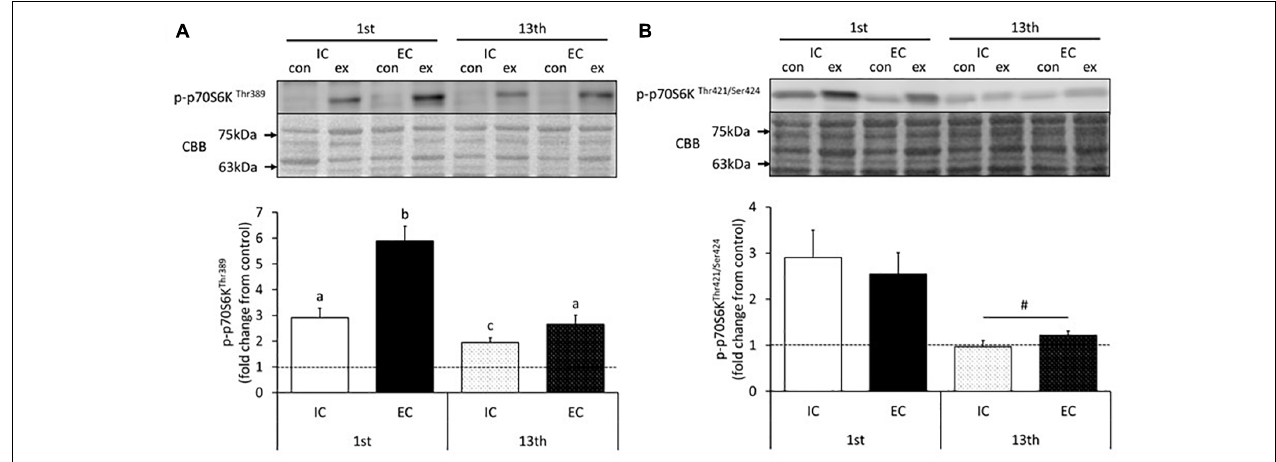
FIGURE 2 | Phosphorylation of p70S6K on Thr389 (A) and Thr421/Ser424 (B) after the 1st and 13th bouts of resistance exercise. Values are means ± standard error (SE). Different letters indicate significant differences. # Main effect of training ( p < 0.05).